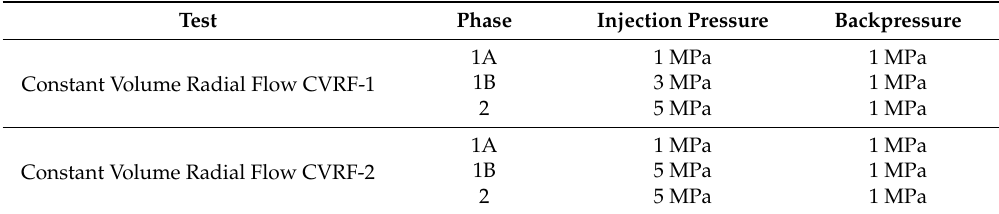
Table 2. Injection pressure and backpressure for the CVRF-1 and CVRF-2 experiments during the different testing phases.